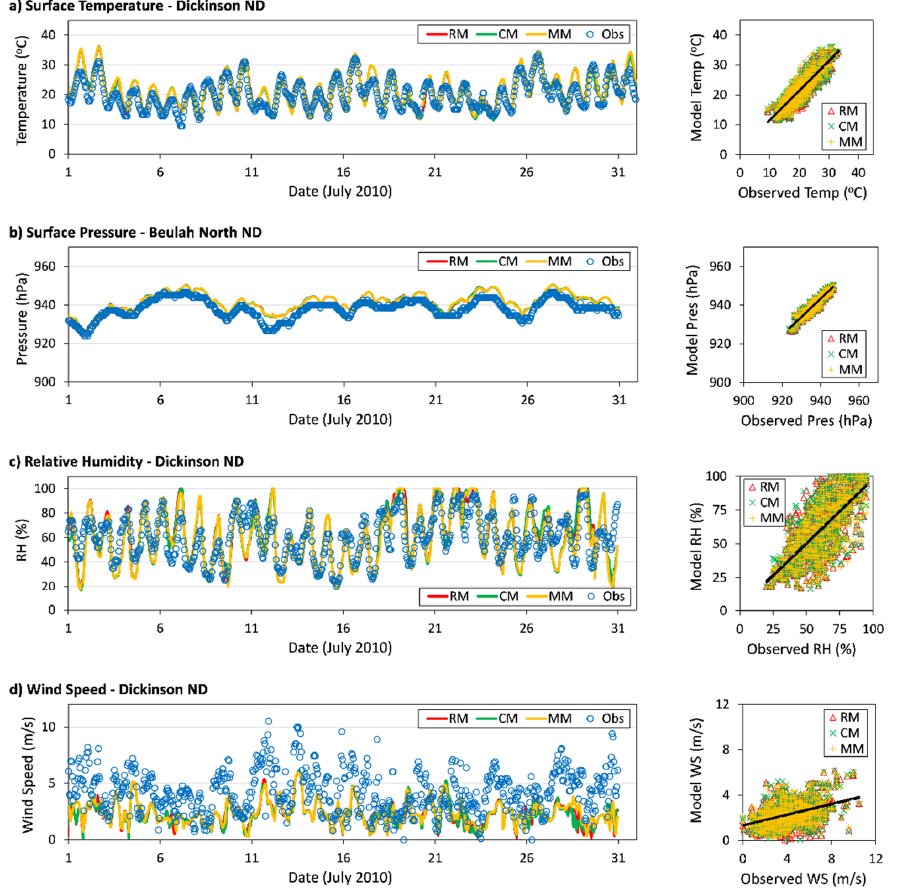
Figure 2. Hourly observed (Obs) and predicted ( a ) temperature at 2 m, ( b ) wind speed at 10 m, ( c ) surface pressure, and ( d ) relative humidity from RACM-MADE/SORGAM (RM), CBMZ-MOSAIC (CM), and MOZART-MOSAIC (MM) chemistry-aerosol mechanisms. Time series shown on left, with scatter plots of predicted vs. observed values on the right.